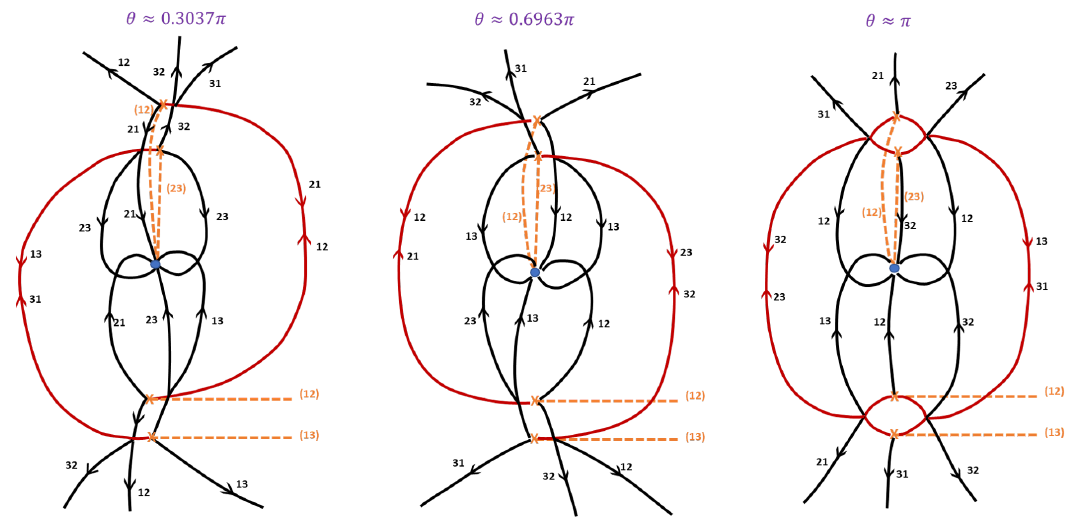
Figure 3 . Zoomed-in Stokes graphs at θ ≈ 0 . 3037 π, 0 . 6963 π, π , where we have taken u 1 = 0 . 3 , u 2 = 0 , Λ = 1 and we focus on details near z = 0 . The irregular singularity at z = 0 is denoted by a blue dot. The irregular singularity at z = ∞ is not shown in the figure. Branch points are represented as orange crosses, while orange dashed lines denote the choice of branch cuts. Finite segments or webs are colored in red. In the class S setup [52, 53, 69] they correspond to the trajectories of 6d BPS strings which give rise to 4d BPS states after the twisted compactification on C